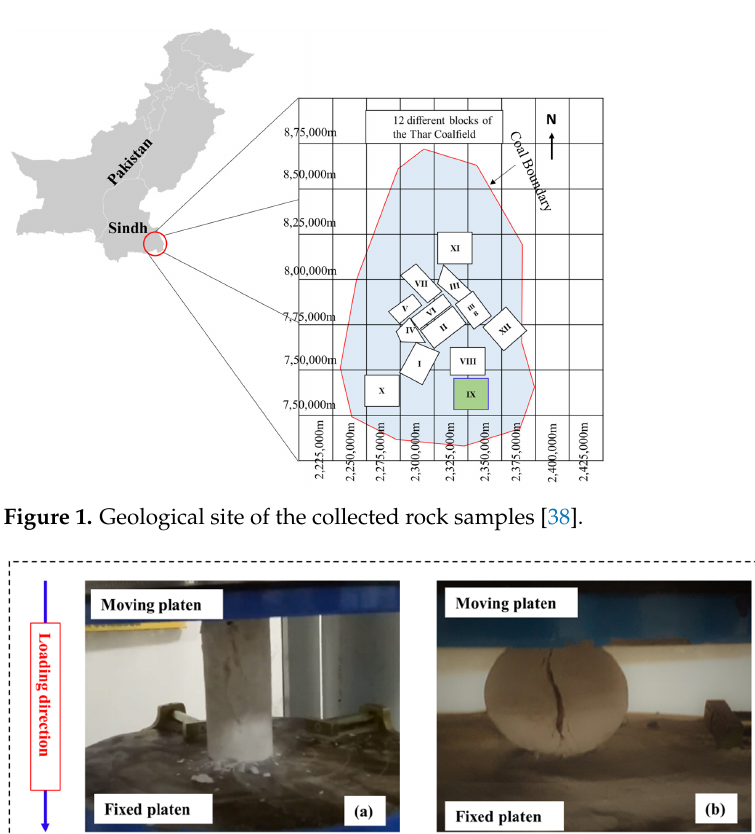
Table 1. Previous studies using intelligent methods to predict UCS.